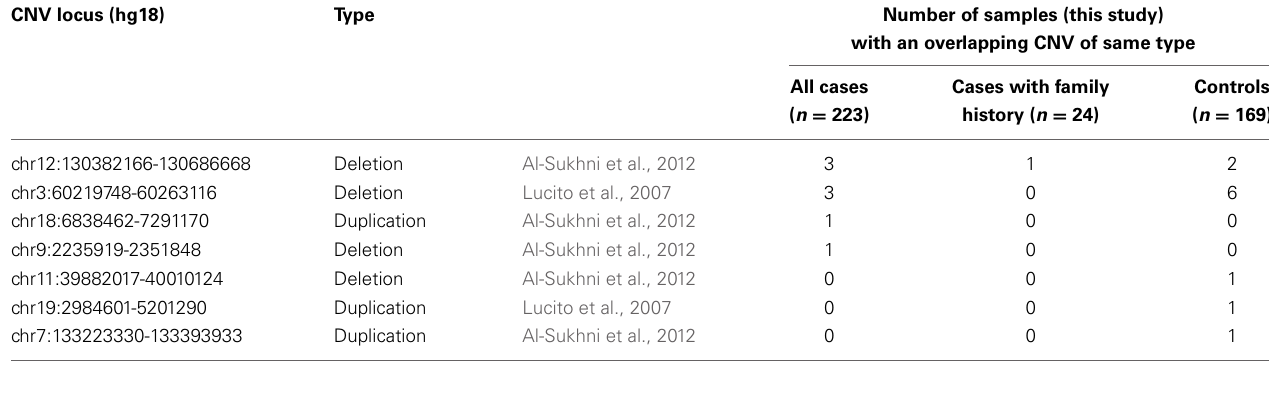
Table 5 | Overlap between discovery CNVs (this study) and CNVs previously implicated in familial pancreatic cancer.